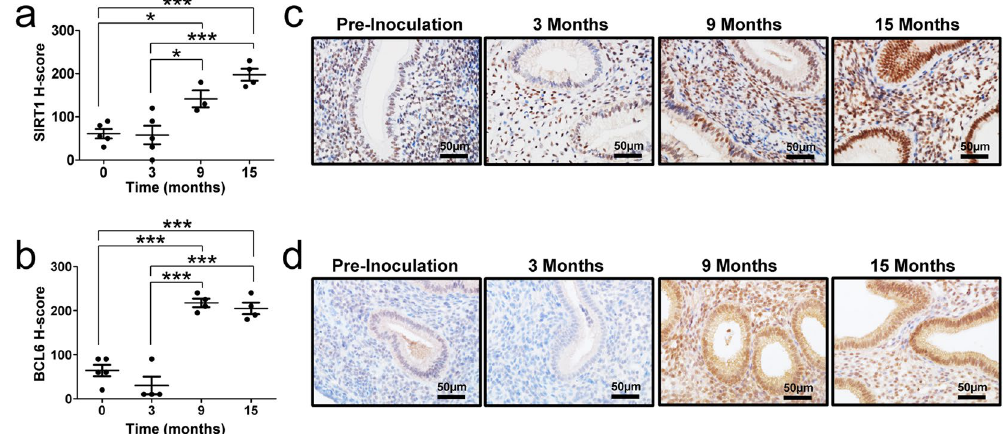
Figure 4. Levels of SIRT1 and BCL6 proteins during progression of endometriosis in a baboon model. ( a and b ) H-score of SIRT1 ( a ) and BCL6 ( b ) expression in endometriosis baboon model induced by intraperitoneal inoculation of menstrual endometrium during progression of endometriosis. The results represent the mean ± SEM. * p < 0.05 and *** p < 0.001. ( c and d ) Representative photomicrograph of immunohistochemical staining of SIRT1 ( c ) and BCL6 ( d ) in the baboon endometrium of pre-inoculation and 3, 9 and 15 months post-inoculation during endometriosis progression.